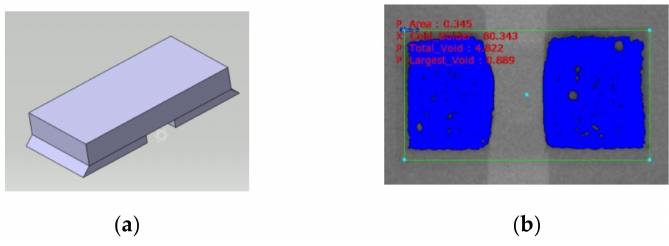
Figure 3. ( a )Three-dimensionalmodelwithLEDchipandsolderjointsand( b )X-rayimageofthesolderjoints. Table 3. Geometric dimensions of the 3D model. LED, light emitting diode.